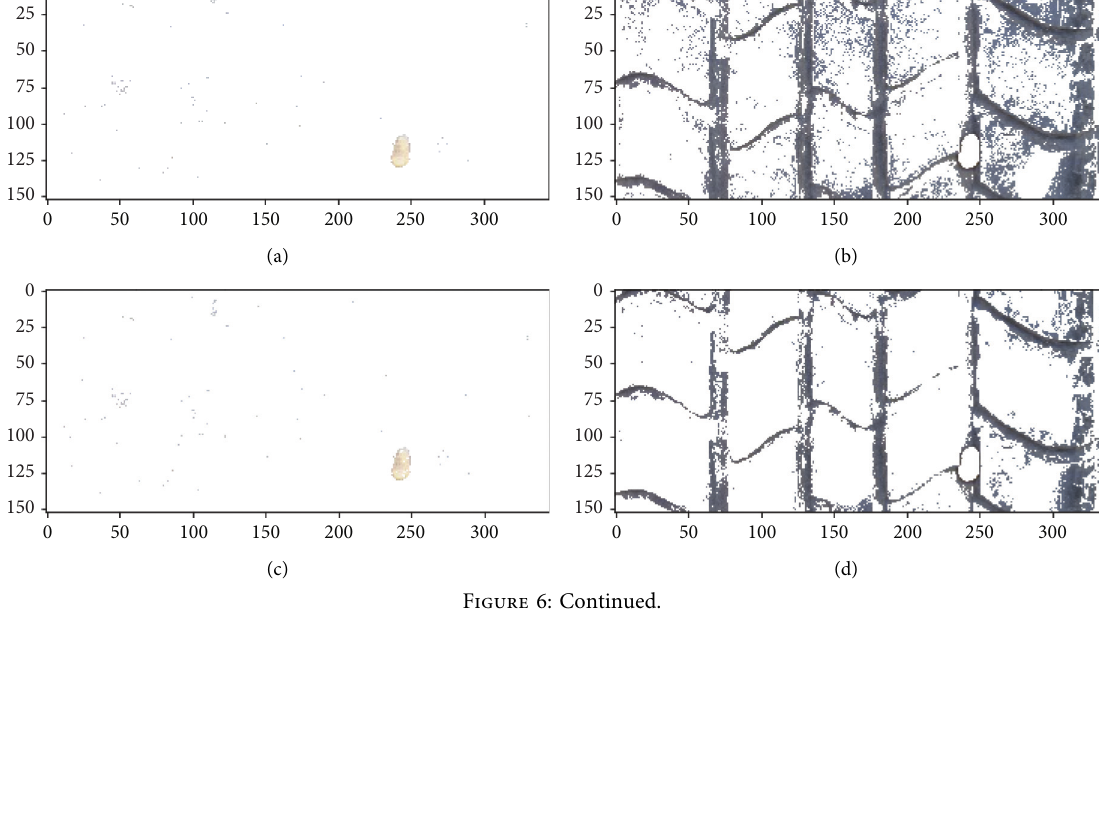
Figure 5: Clustering results on Tyre #1 (318 × 80 pixels, p � 99, N � 25440, and n k � 2. (c) Our algorithm with k � 3. (d) k -means with k � 3. (e) Our algorithm with k � 4 (f) k -means with k � 4.